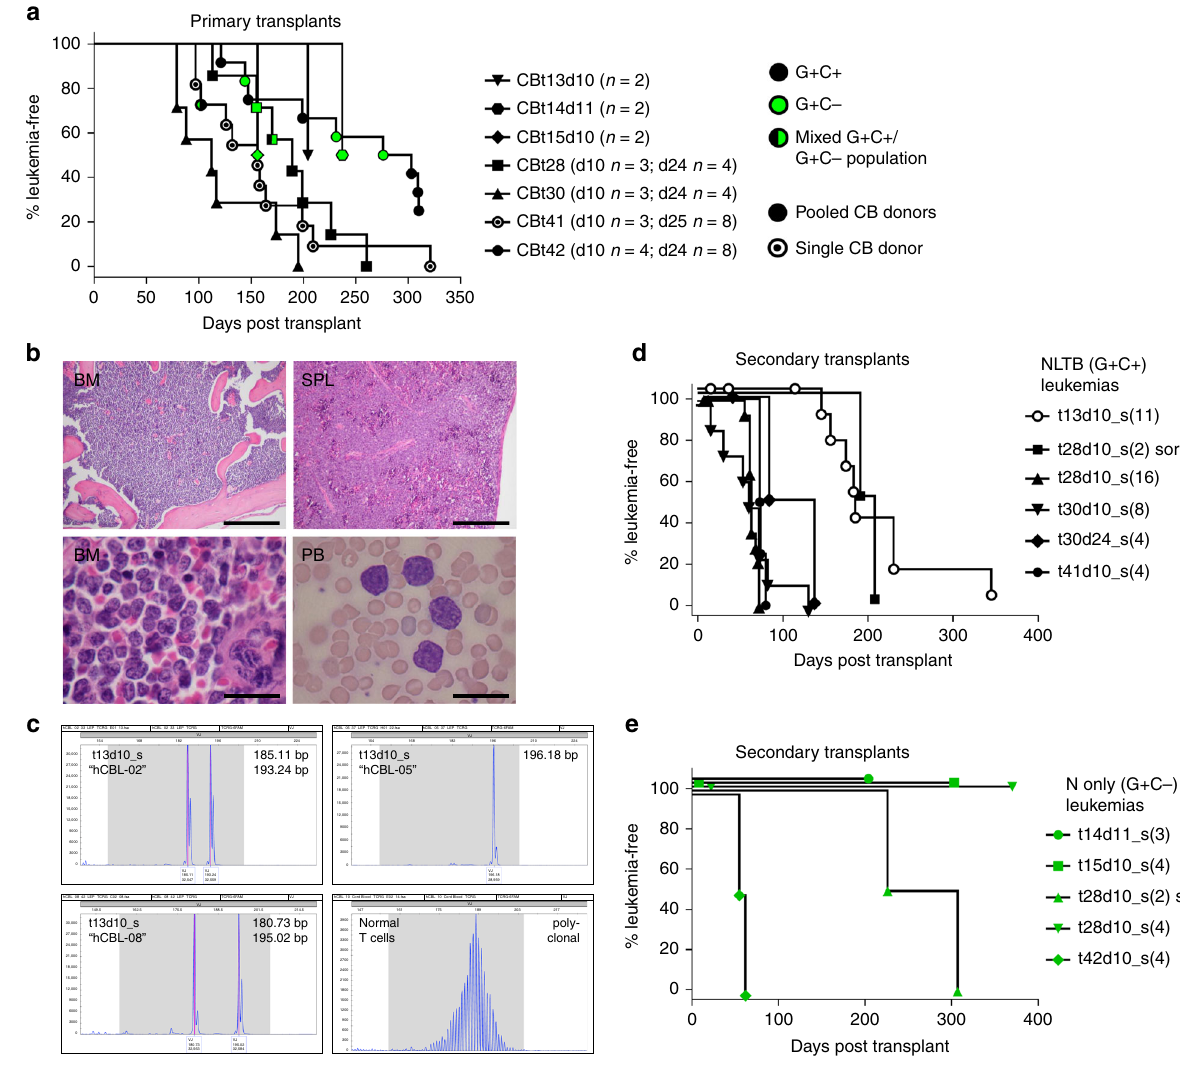
Fig. 2 De novo transformation of CB cells by NOTCH1 plus LMO2-TAL1-BMI1. a Kaplan − Meier survival curves for primary recipient mice. Mice were injected with CB cells transduced with N(GFP) + LTB(Cherry) lentiviruses. Data from seven independent experimental trials are depicted with n